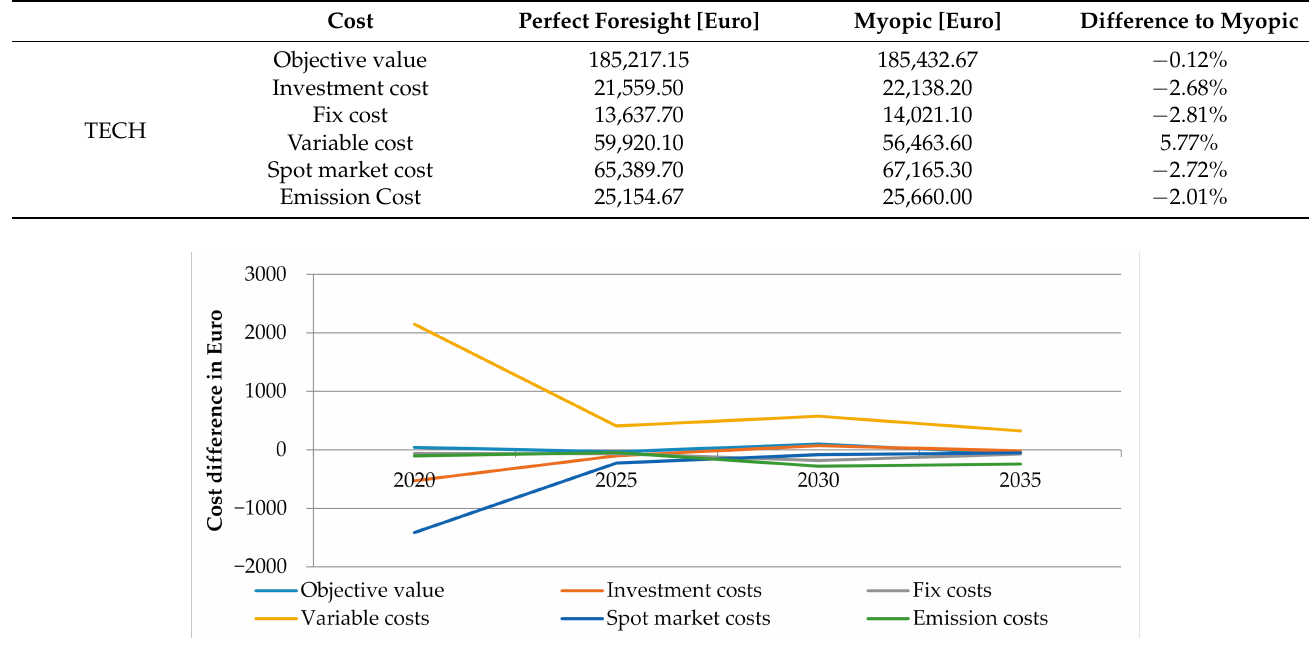
Figure 8. Cost difference between the two approaches over the optimization period.